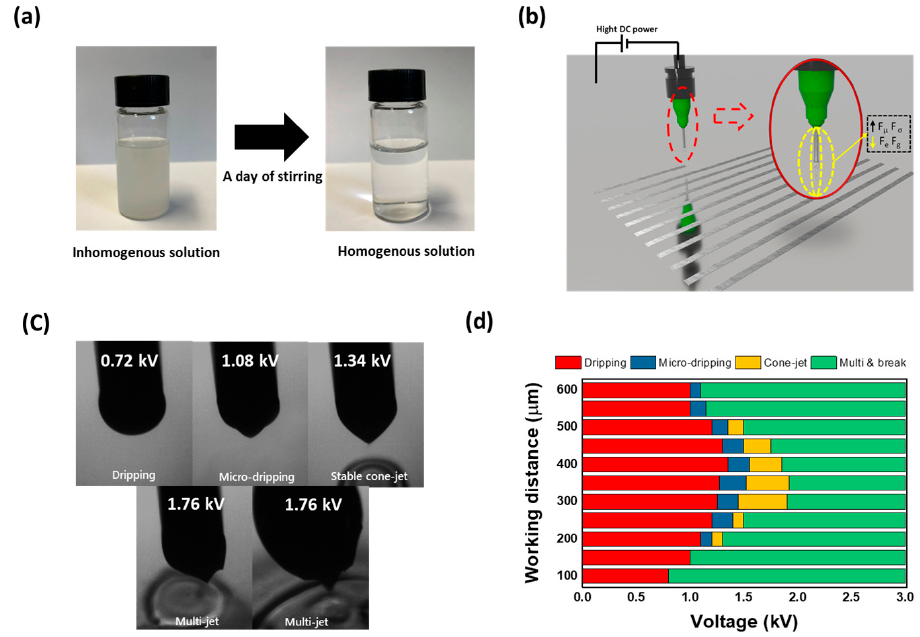
Figure 1. ( a ) ZTO ink for the printing process with as-fabricated and stirred one, and ( b ) schematic illustration of EHD jet printing process. ( c ) Various jetting behaviors, depending on the electrical bias and fabricated lines with micro-dripping and cone-jet mode. ( d ) Summary plots, including the EHD jet printing modes of ZTO dependent on the applied voltage and operation distance.